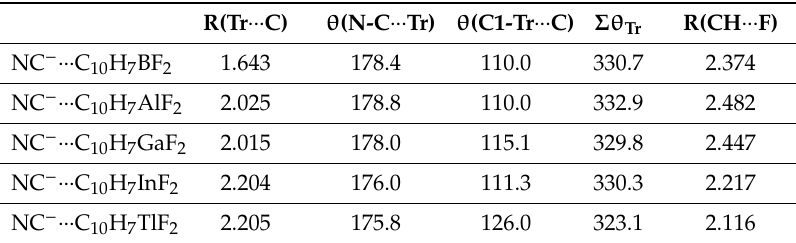
Figure 4. Optimized geometries of complexes of NC - with C 10 H 7 TrF 2 (left) and C 10 H 6 NH 2 BF 2 (right) at MP2 / aug-cc-pVDZ level. Table 6. Structural parameters (distances in Å, angles in degrees) in complexes of C 10 H 7 TrF 2 with NC − calculated at the MP2 / aug-cc-pVDZ level of